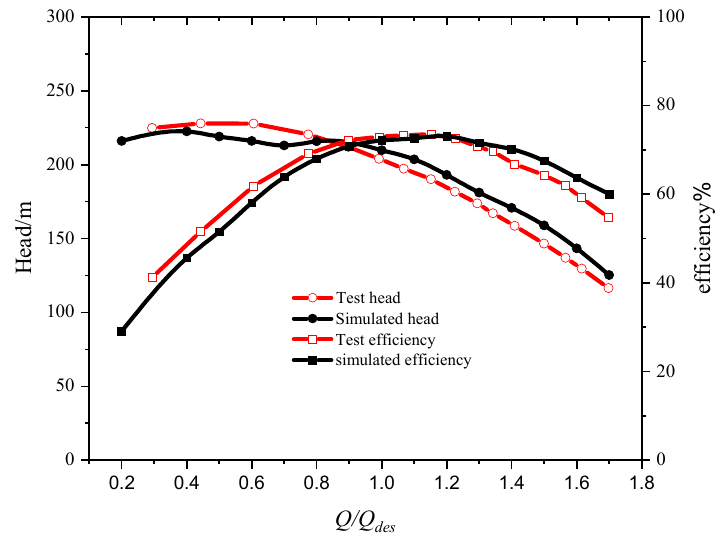
Figure 5. The characteristic curve of the LNG submerged pump.